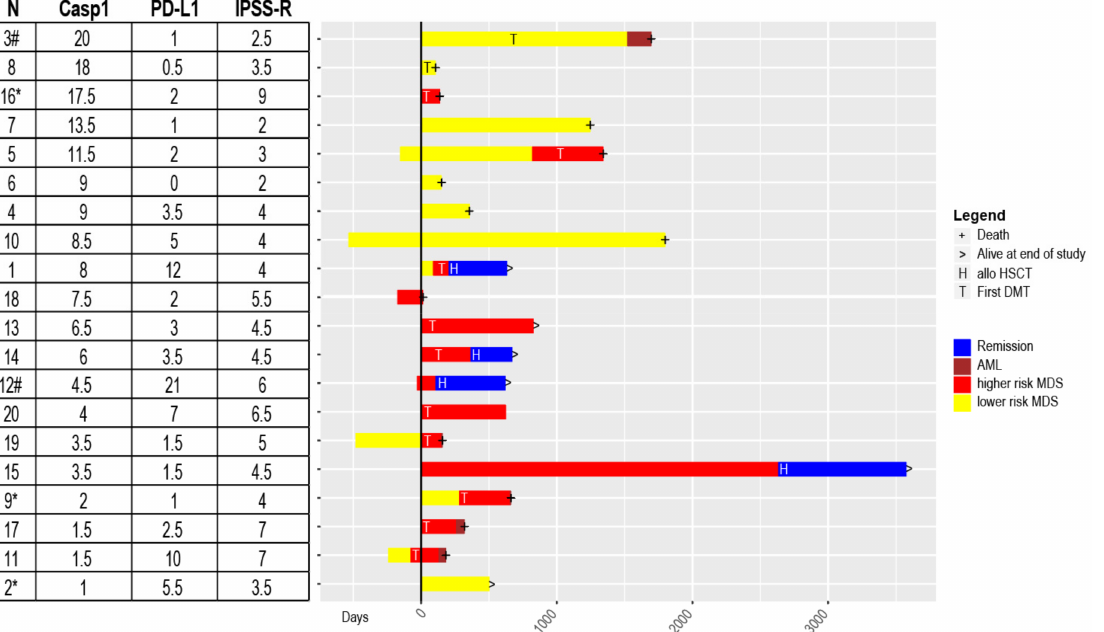
Figure 4. Clinical course of MDS patients ranked according to Casp1 expression. Numbers are according to Supplementary Table S1 with patient numbers [N], Casp1 and PD-L1 [H-scores] expression and International Prognostic Scoring System revised [IPSS-R], shown in the table on the left. Patients were ranked according to the Casp1 expression. The general pattern of Casp1low in higher-risk and Casp1high in lower-risk disease is evident. The five patients that were not included at diagnosis have bars in the negative time-axis. I.e. patient 11 received 2 cycles of lenalidomide four months before inclusion, all others were DMT-naïve. Only patients undergoing allo-HSCT achieved durable remission. IHC pictures of patients 3 and 12 with # are shown in Figures S1 and S2, respectively. Patients 2, 9, 16 with * had unexpected patterns and were investigated in more